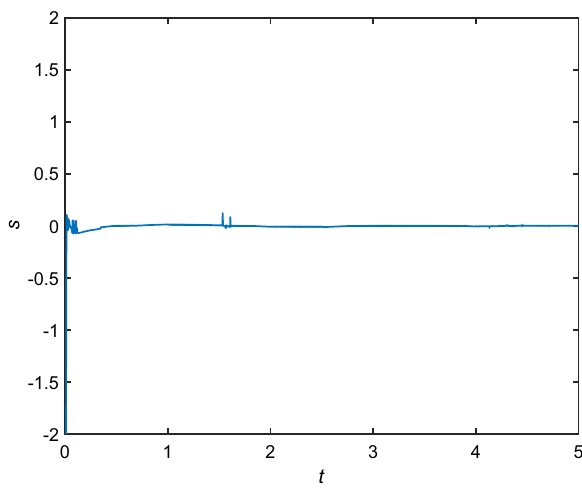
Fig. 4 The evolution of sliding mode surface s